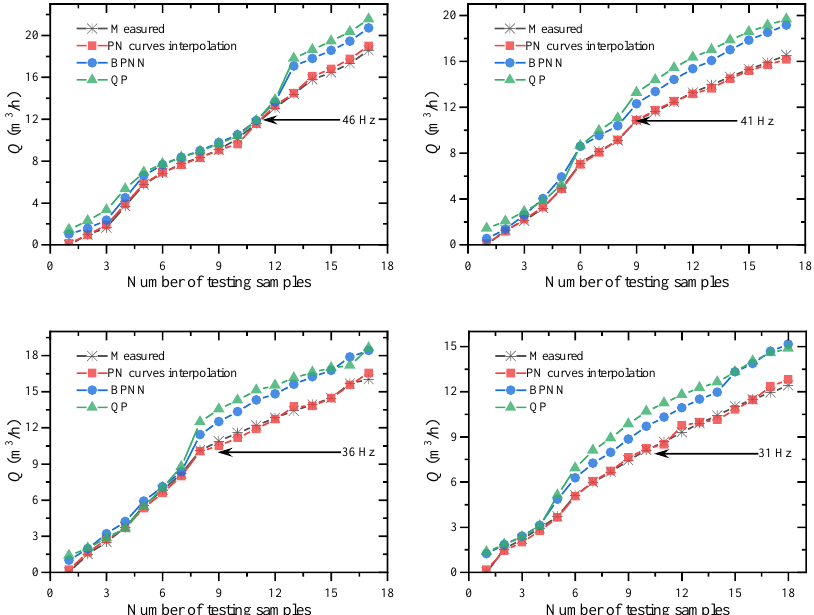
10 of 16 Figure 11. Fluctuation of the shaft power. 5. Results and Discussion